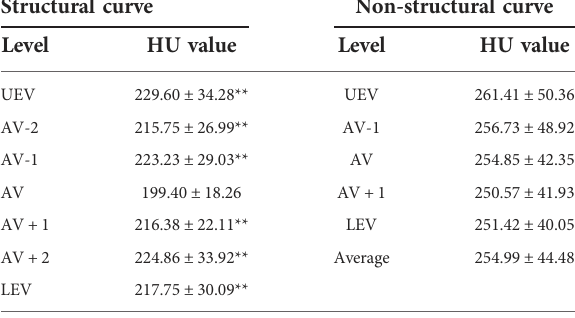
TABLE 4 Variation degree of bone quality in different regions of the structural curve in AIS patients.